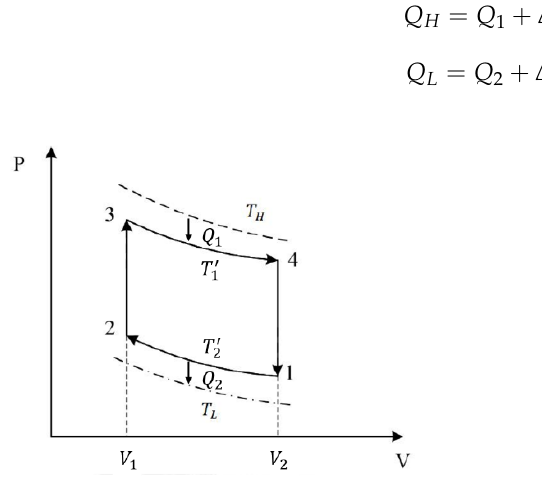
Figure 1. P-V process of the Stirling cycle in finite-time thermodynamics.